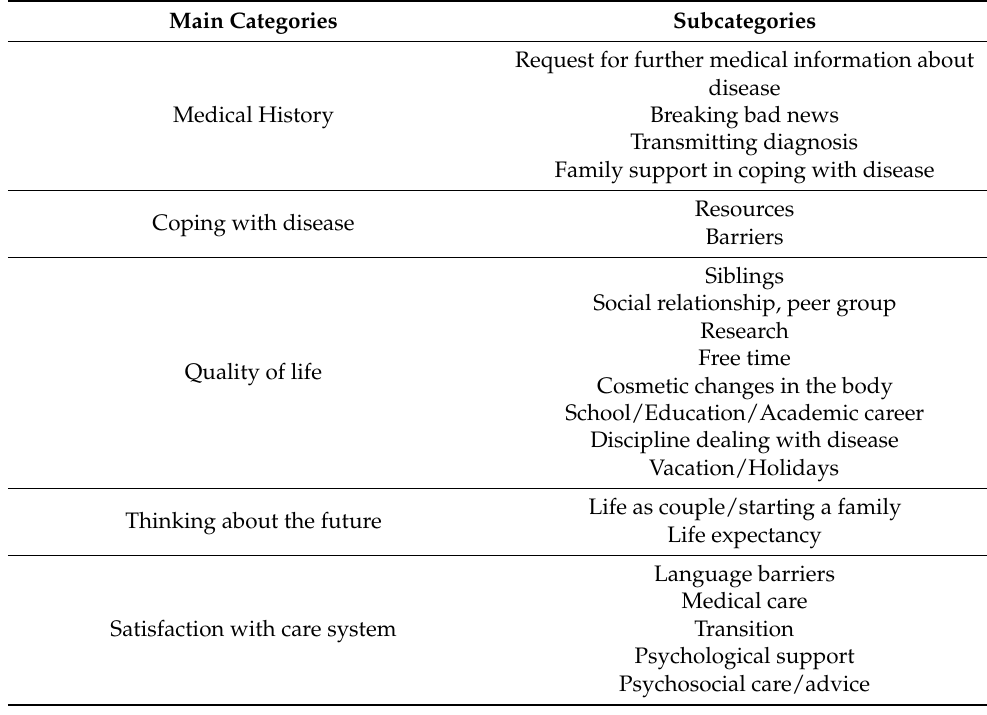
Table 2. Overview of main categories and